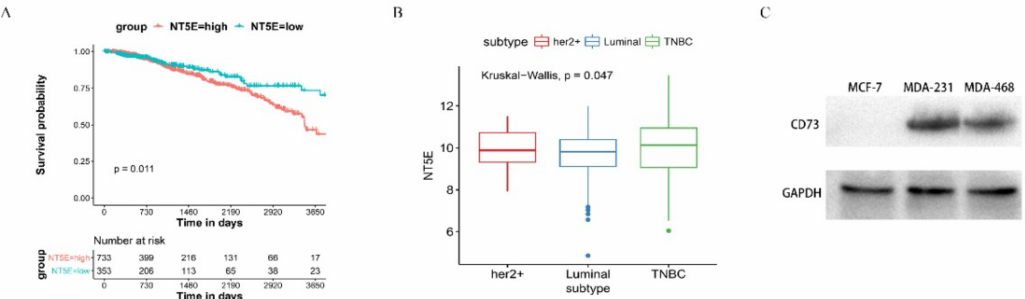
Figure 3. The expression of CD73 and the survival probability in breast cancer: ( A ) a Kaplan–Meier curve was used to detect the overall survival (OS) of CD73 in BC patient, using best separation; ( B ) the expression level of CD73 in Her2+, luminal, and triple-negative breast cancer (TNBC) patients; ( C ) Western blot assay of expression level of CD73. Data are representative of at least three independent experiments and means ± SD were